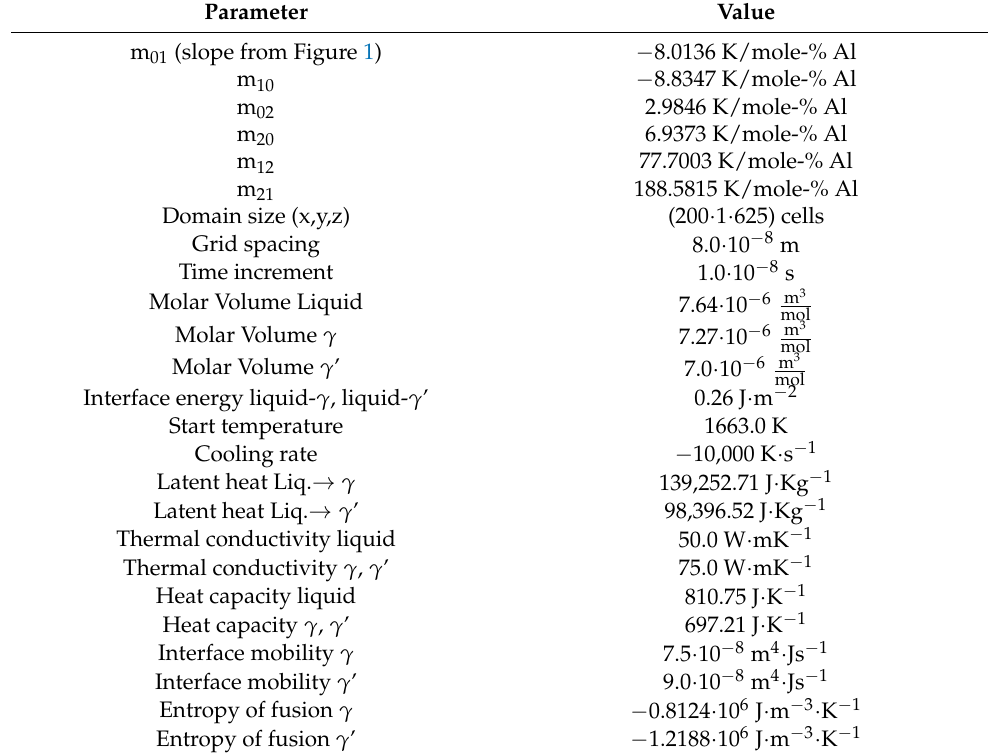
Table 2. Relevant input parameters applied in the solidification